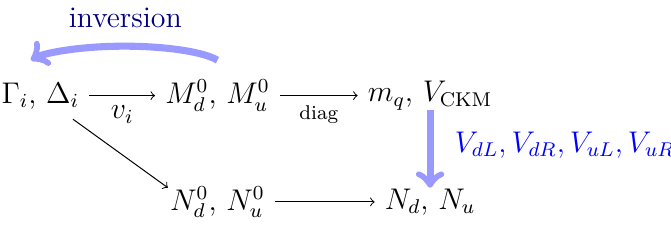
Figure 1 . In a generic multi-Higgs model, one begins with Γ i , ∆ i , computes the mass matrices and diagonalizes them. This procedure, indicated by thin arrows, is usually irreversible. In certain models, one can perform inversion (thick light blue arrows), which allows one to pass directly from the quark properties to the FCNC